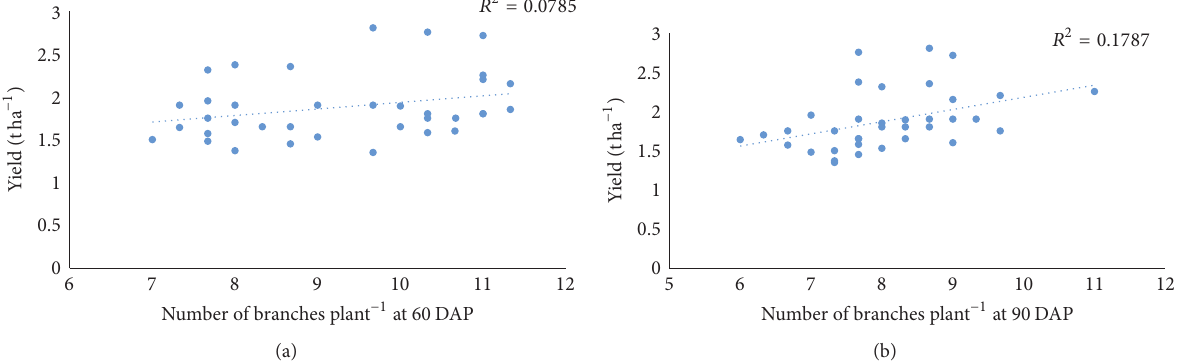
Figure 4: Relationship between number of branches/plant at 60 DAP and number of branches/plant at 90DAP with yield of peanut (mean of two